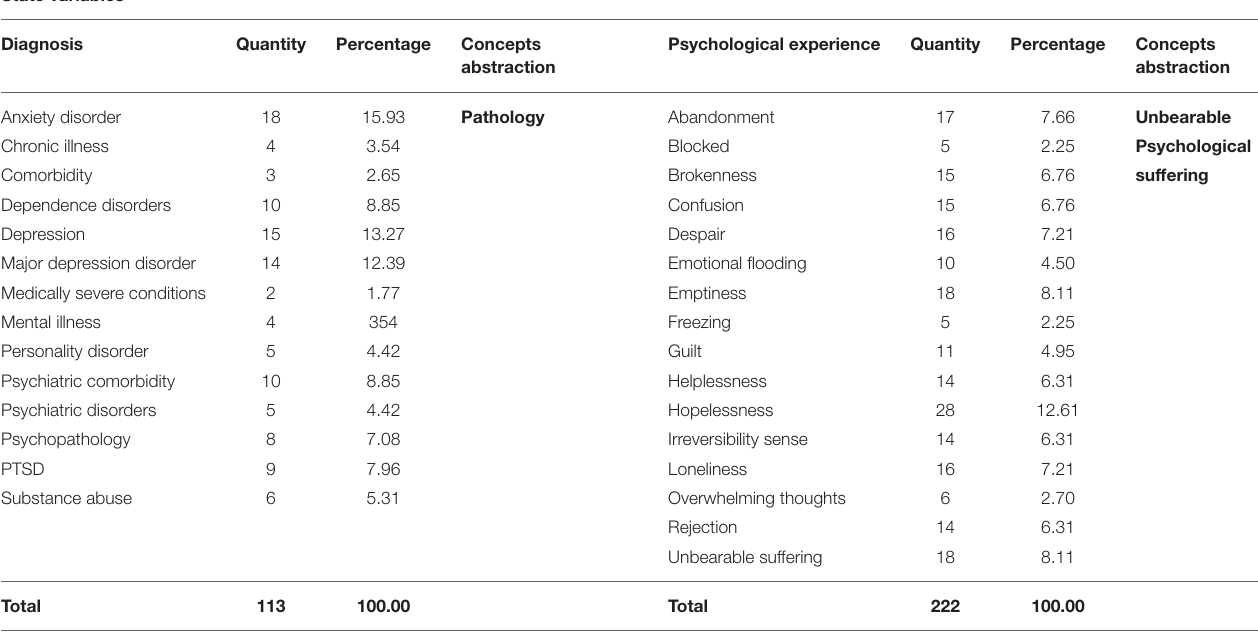
TABLE 2 | Psychological states (transient) obtained in concepts